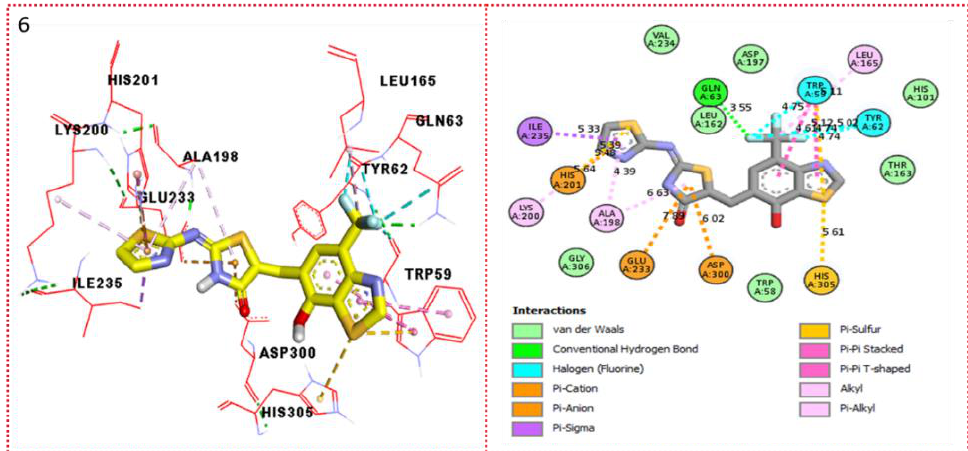
Figure 12. Protein – ligand interaction profile for active analogue against α‐ glucosidase represents the surface of the corresponding enzyme and indicates the PLI profile for compound 6 .